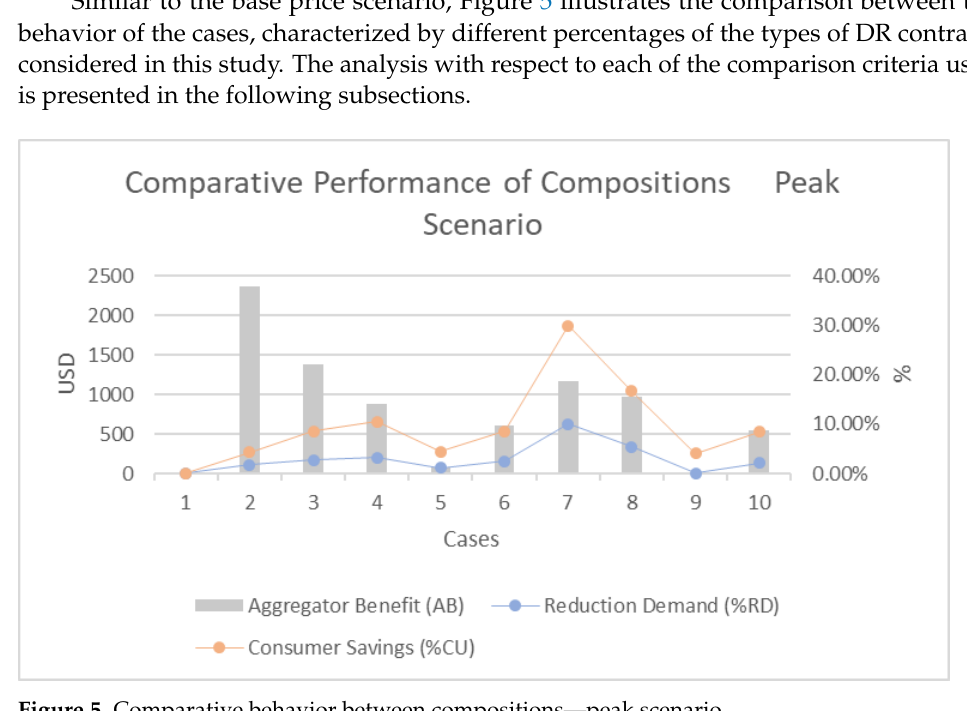
Figure 5. Comparative behavior between compositions—peak